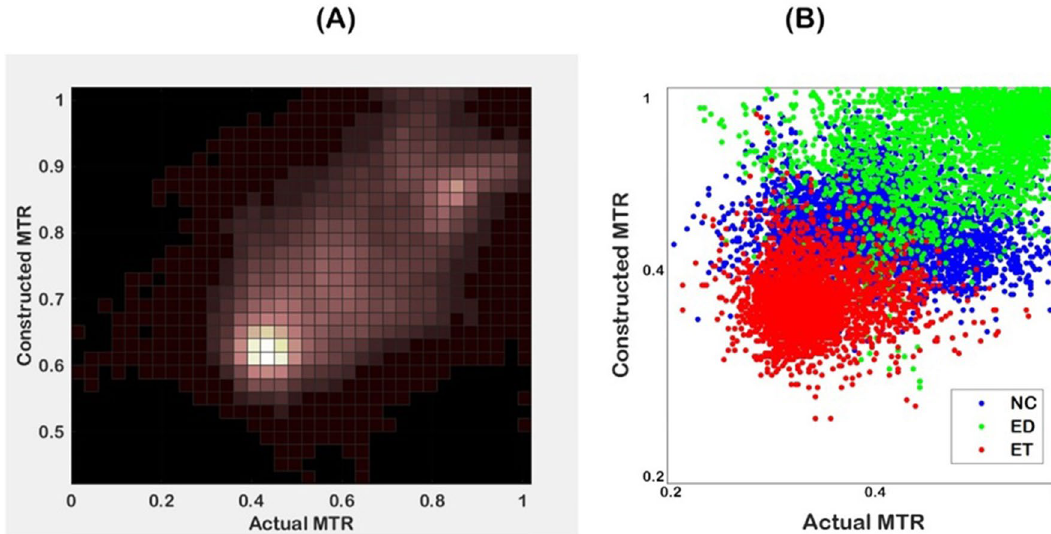
Figure 3. Demonstration of ( A ) bivariate histogram of the constructed in comparison with actual MTR asym images; and ( B ) association of the clusters of tumor tissues in the constructed versus actual MTR asym